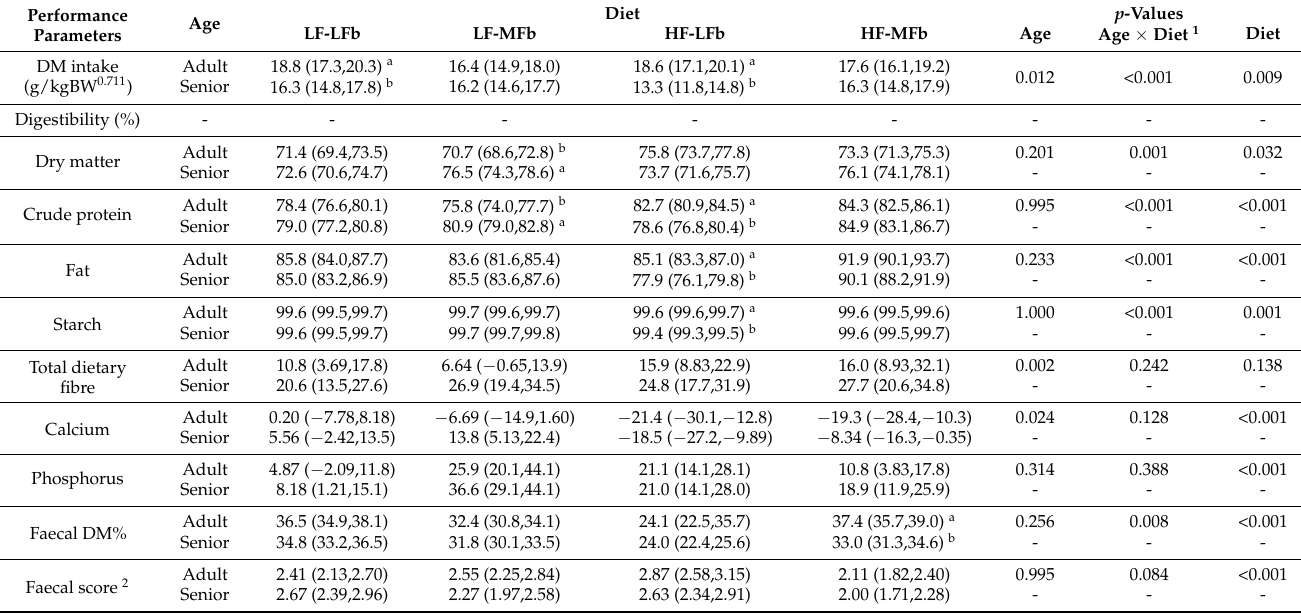
Table 6. Mean and 95% confidence intervals (CI) for dry matter (DM) intake, apparent digestibility of DM and nutrients, faecal DM and consistency score in adult (1–5 years) and senior (7–13 years)